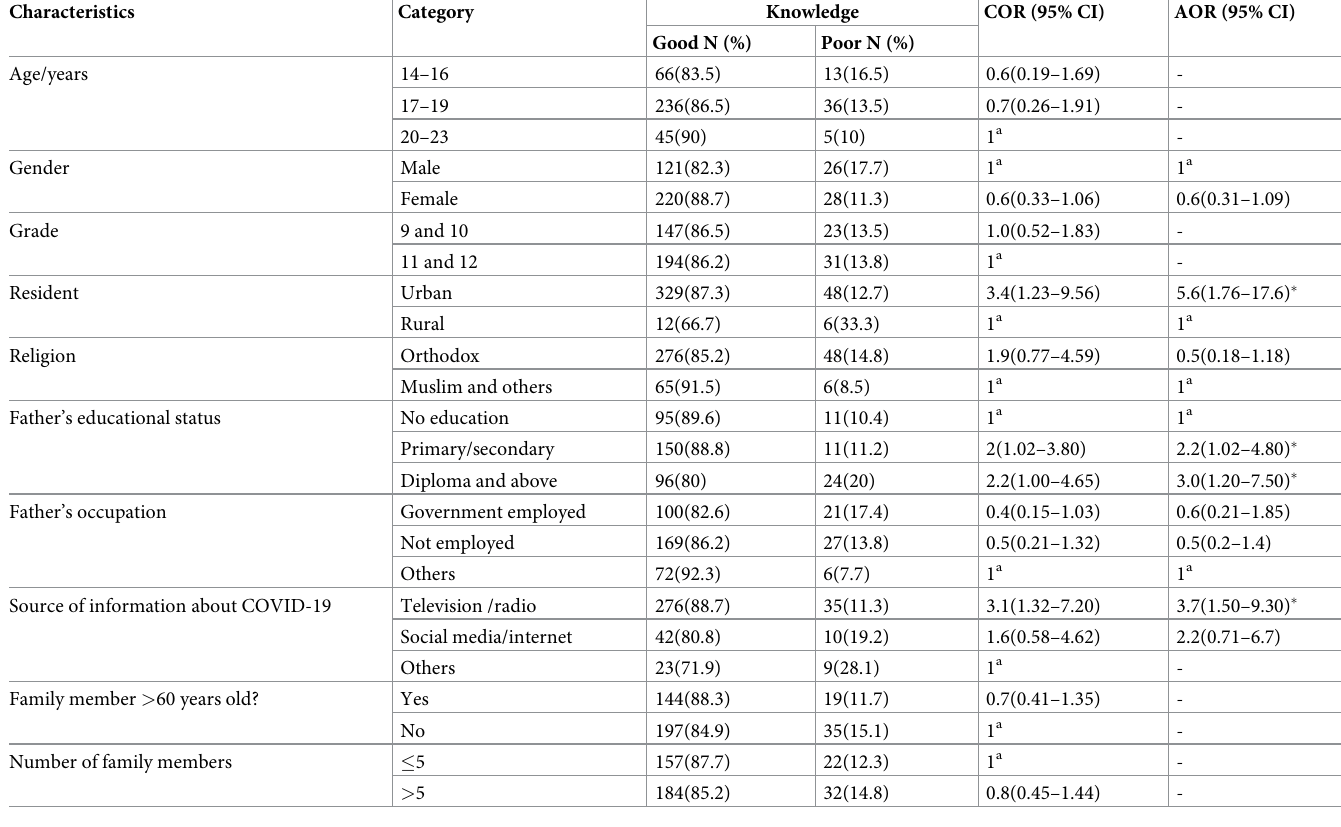
Table 5. Factors associated with knowledge about COVID-19 among secondary school students in Gondar town, Northwest Ethiopia, 2021.